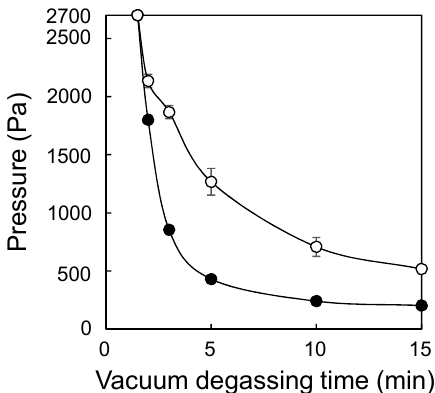
Figure 1. Relationship between pressure in the vacuum desiccator and vacuum degassing time. The sealed glass jar contained monomer solution ( ○ ) or did not contain monomer solution ( ● ). Error bars indicate standard deviation.